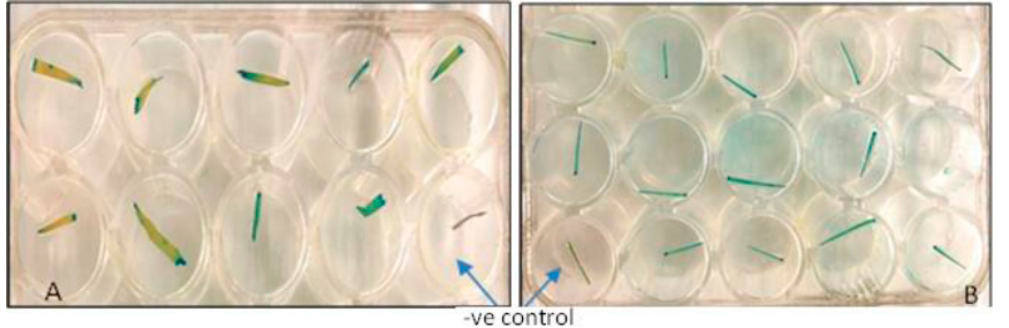
Figure 1. ( A ) Wheat samples showing histochemical GUS staining. ( B ) Rice samples showing histo- chemical GUS staining. histochemical GUS